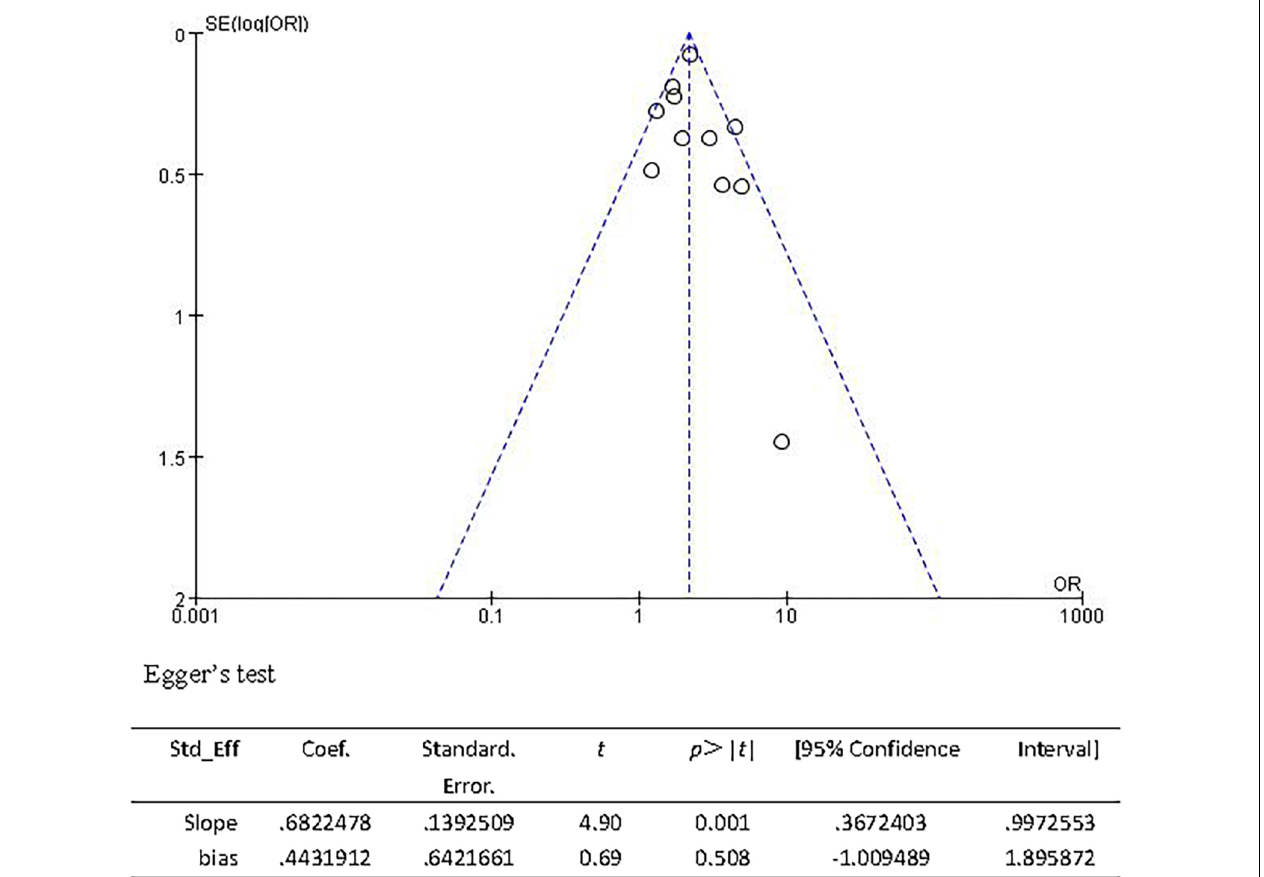
FIGURE 10 | Funnel plot and Egger’s test of studies evaluating the association between CSVD and 3-month